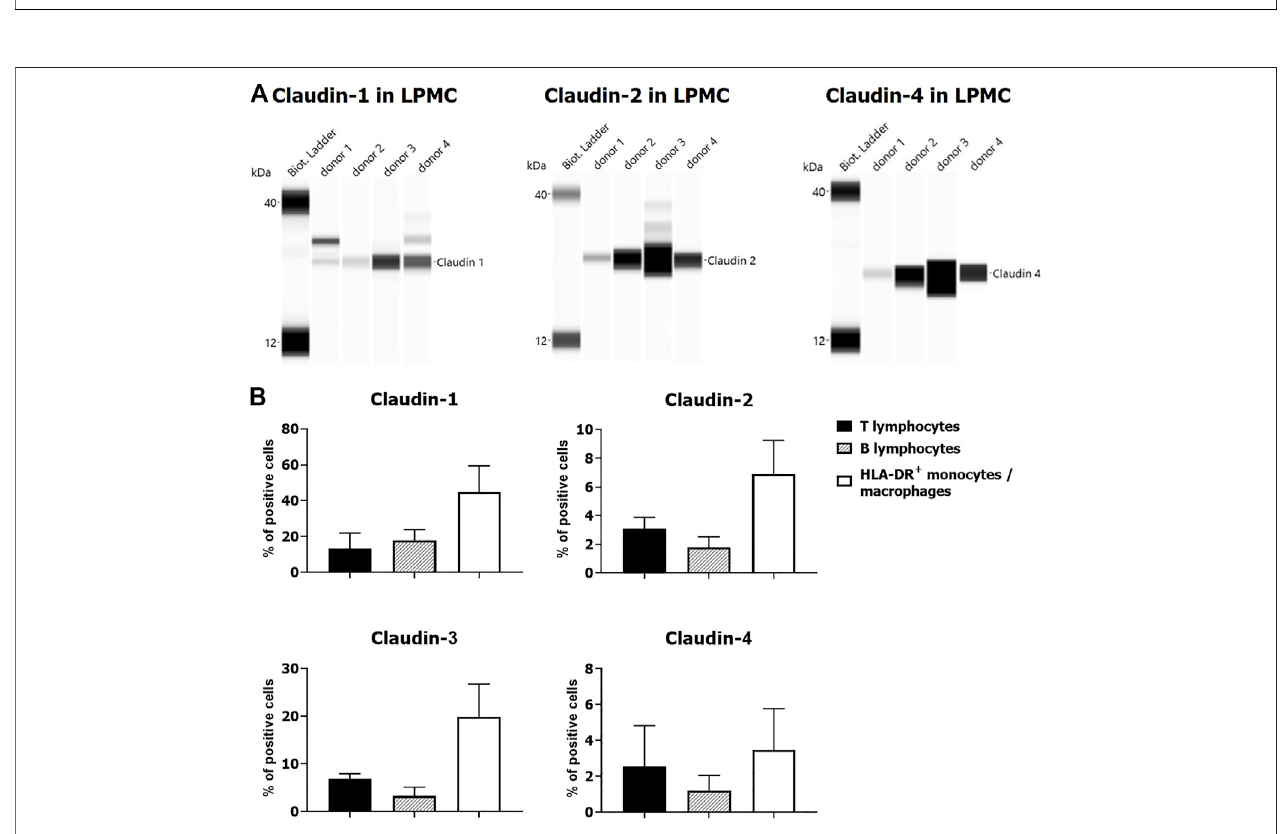
FIGURE 8 | Claudin expression by LPMCs: (A) Western blot, four UC donors (colon); (B) fl ow cytometry: percentage of claudin positive cells (mean ± SD) within individual LPMC subpopulations: two UC (colon) and two CD (terminal ileum) donors.